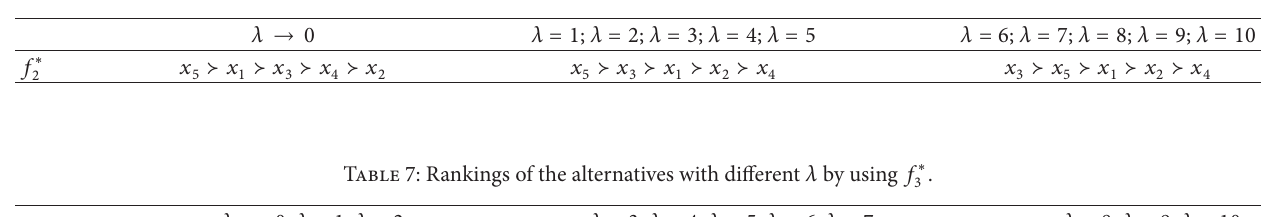
Table 6: Rankings of the alternatives with different 𝜆 by using 𝑓 ∗ 2 .